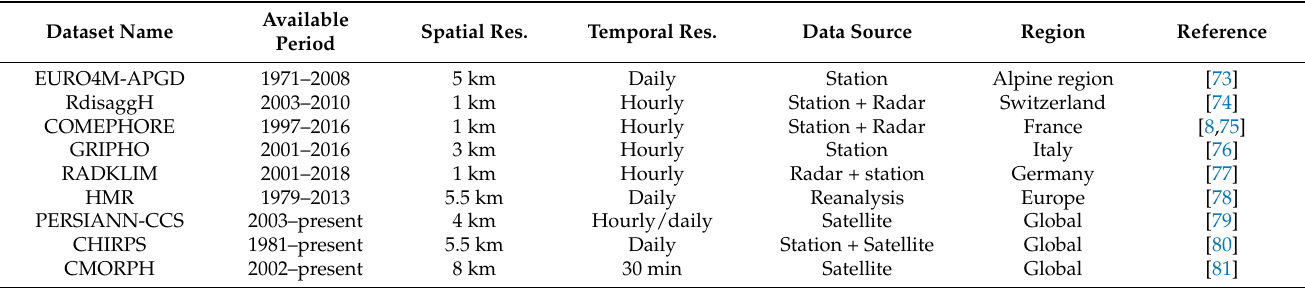
Table 1. The main characteristics of the observational datasets used in the study.